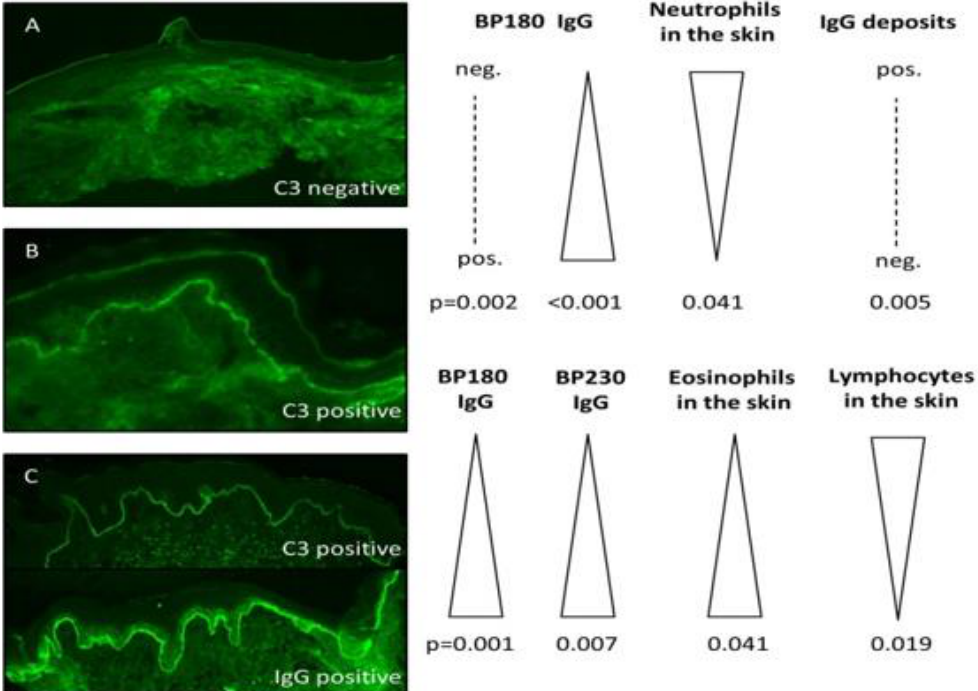
Figure 2. Visual abstract summarizing the main study findings. The figure includes three illustrative images of direct immunofluorescence microscopy from perilesional skin biopsies of BP patients. The immunoserological and histological features were compared between three groups. The comparison between ( A ) and ( B ) represents a comparison between patients without and with C3 deposition by direct immunofluorescence, respectively. The comparison between ( B ) and ( C ) represents a comparison between patients with isolated C3 deposition and patients with C3 deposition alongside IgG/IgA, respectively.